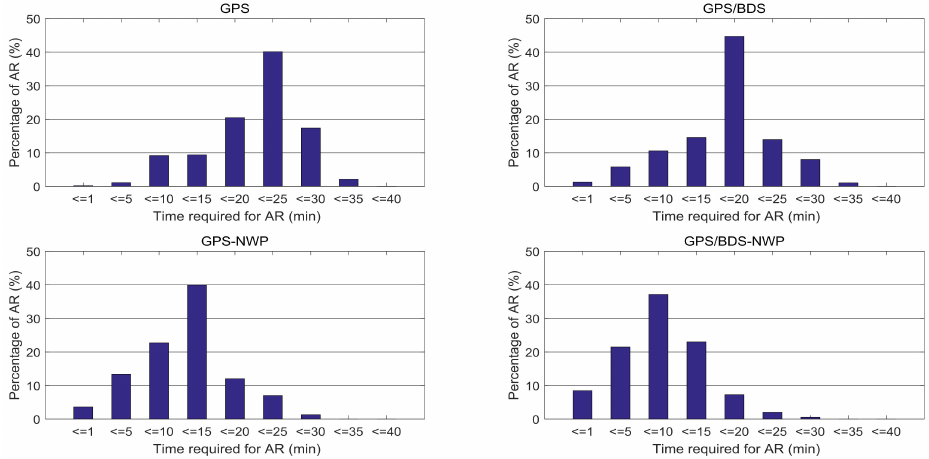
Figure 7. Time required for AR (baseline: 80 km).